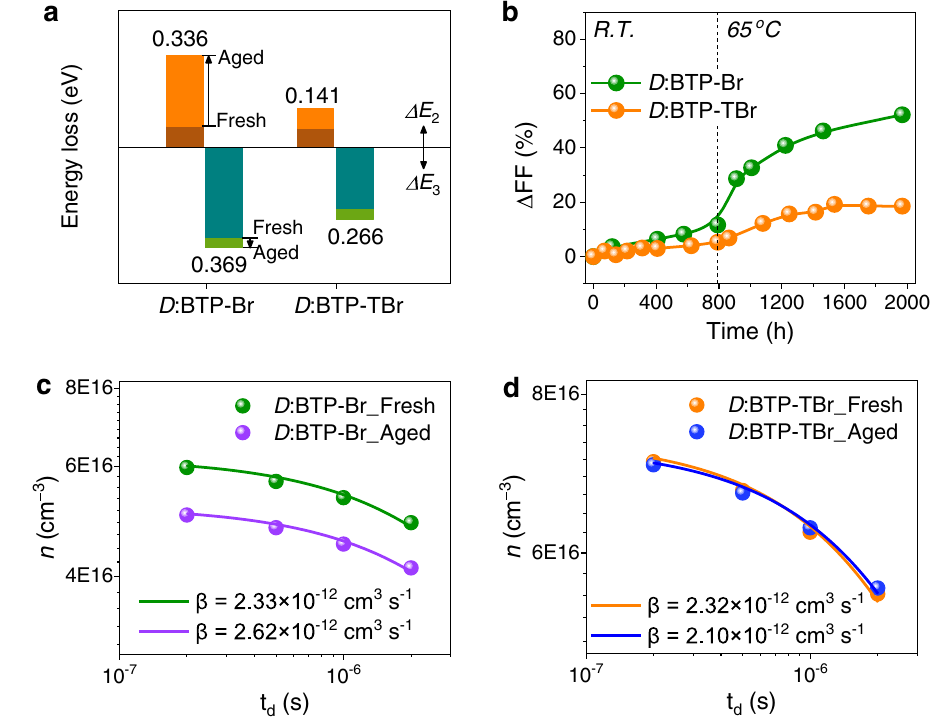
Fig. 4 | Effect of physical aging on energy loss and charge recombination. a Comparison of V OC losses for fresh and aged devices. b The FFattenuation ( Δ FF) against aging time for different devices. Extracted charge carrier density ( n ) as a